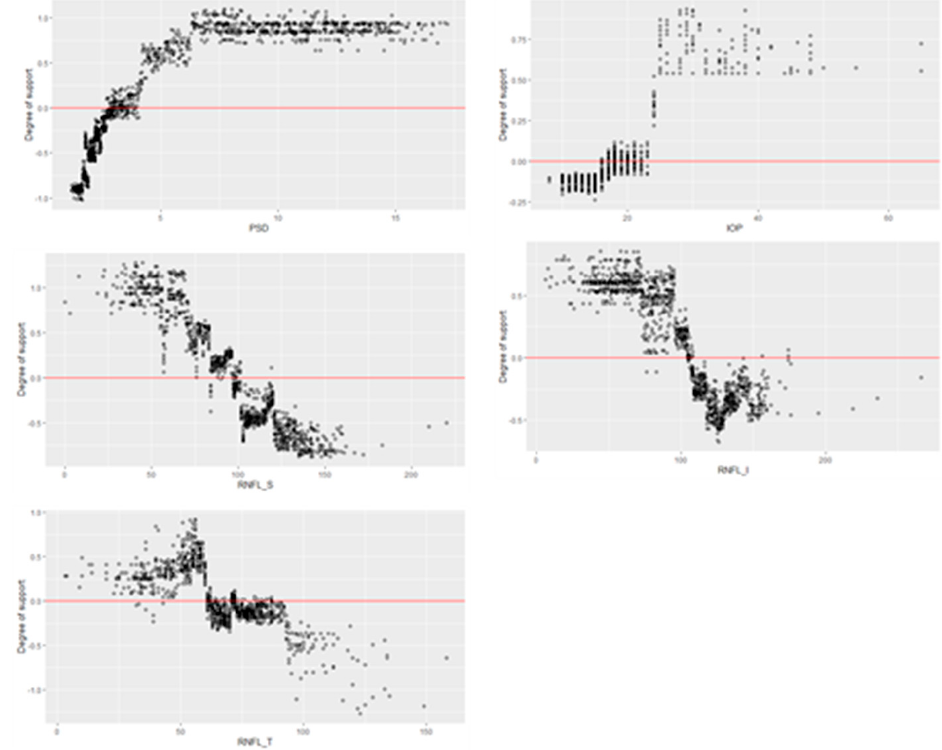
Figure 9. Distributions of degree of support according to the feature values.